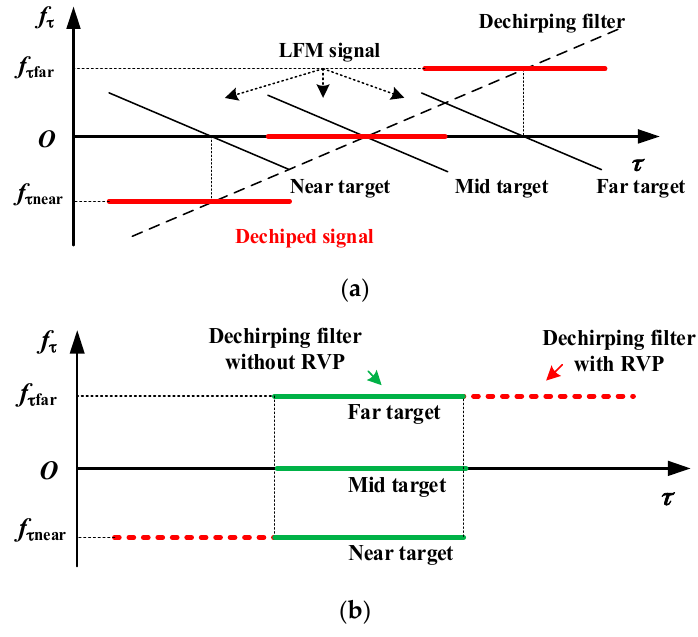
Figure 2. Effects of the ( a ) two dimensional dechirping; and ( b ) residual video phase removal to the signal distributions in the time-frequency domain.